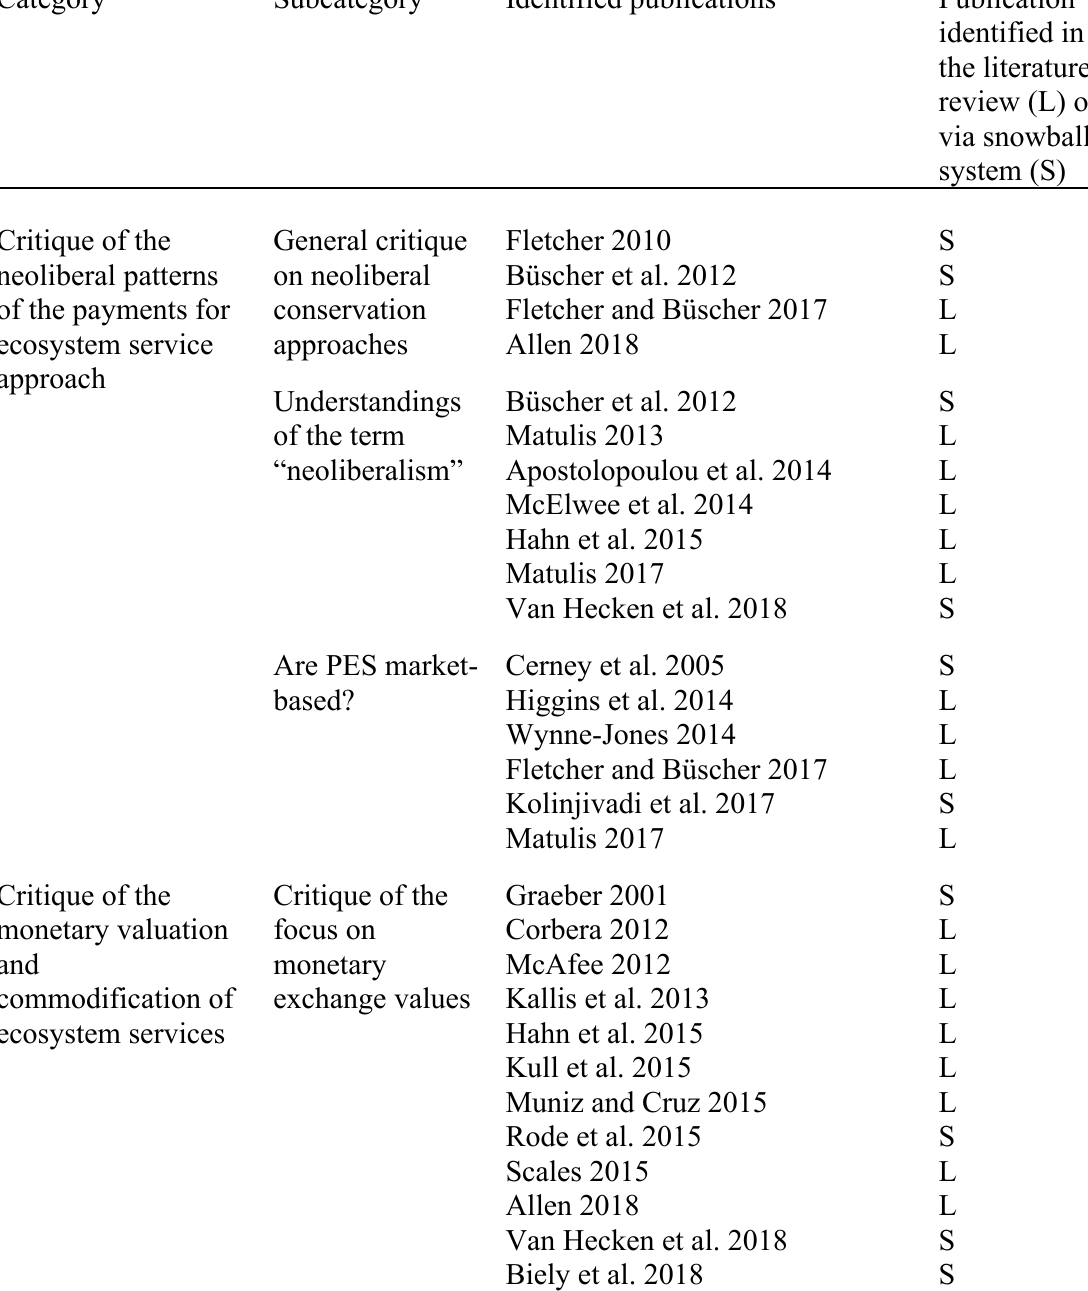
Table A3. Coding system for the systematic literature review addressing critique of the PES approach; cited literature is assigned to the main categories of the coding system and divided into publications directly identified in the literature review and further publications identified based on a snowball